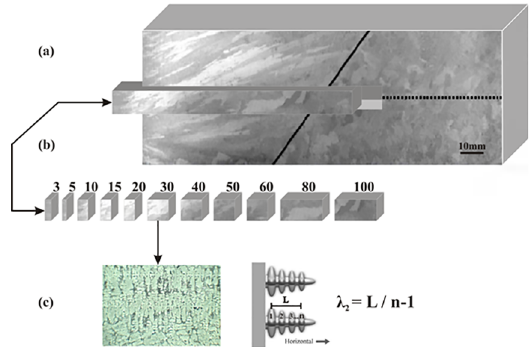
Figure 3. (a) Solidification macrostructure, (b) Removal of samples for microstructural analysis and (c) Technique used for λ